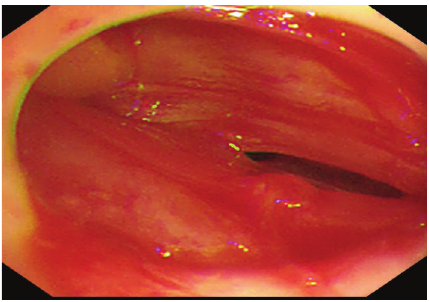
Figure 2: Obliteration of the pleural space due to extensive adhe- sions and pleural